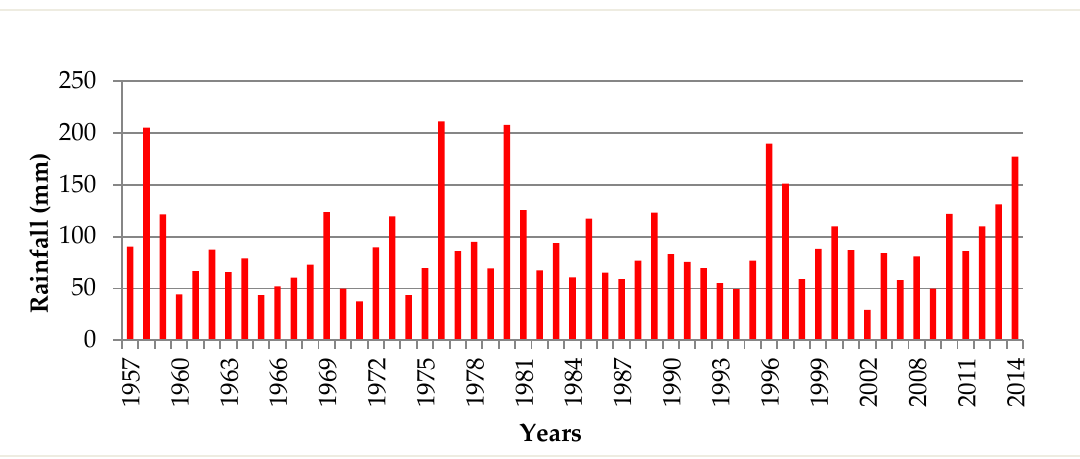
Figure 8. The annual maximum daily rainfall hyetograph of Lahore city.